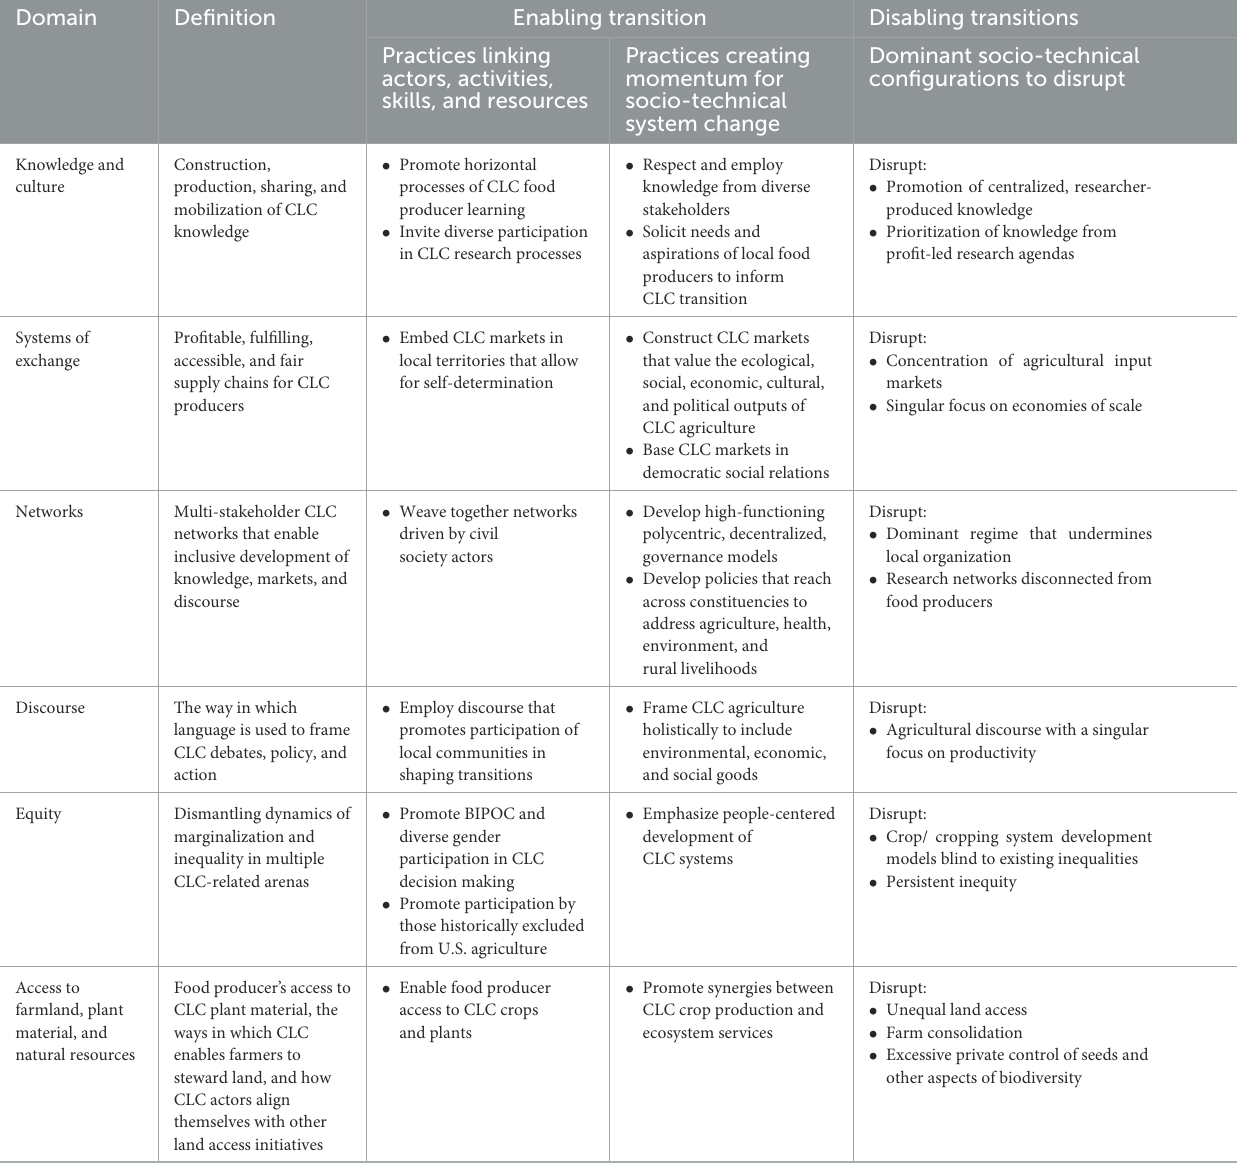
TABLE 1 Domains of transformation and associated practices for CLC transition intermediaries.